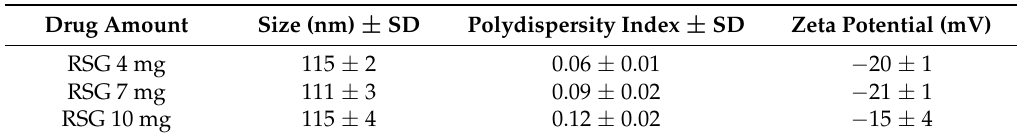
Table 2. Size, PDI, and zeta potential of nanoparticles prepared by nanoprecipitation technique using acetonitrile.